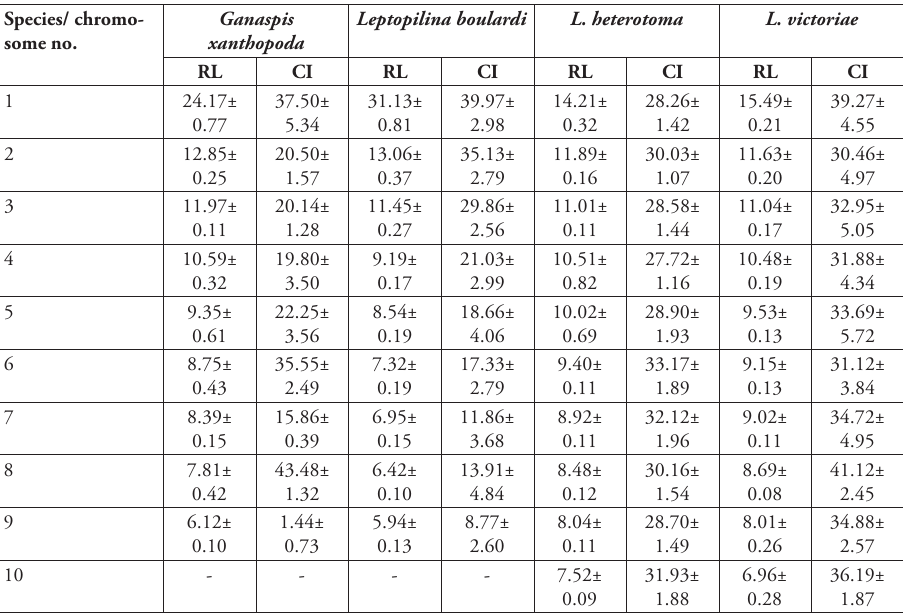
table 2. Relative lengths (RL) and centromere indices (CI) of Drosophila parasitoids. (mean±SE). Strains and numbers of studied metaphase plates are as in Table 1. Centromere indices are: metacentrics: 37.5- 50.0; submetacentrics: 25.0-37.5; subtelocentrics: 12.5-25.0; acrocentrics: 0-12.5, according to Levan et al. (1964). Ganaspis Leptopilina boulardi L. heterotoma L. victoriae Species/ chromo­ xanthopoda some no. RL CI RL CI RL CI RL CI 1 24.17±